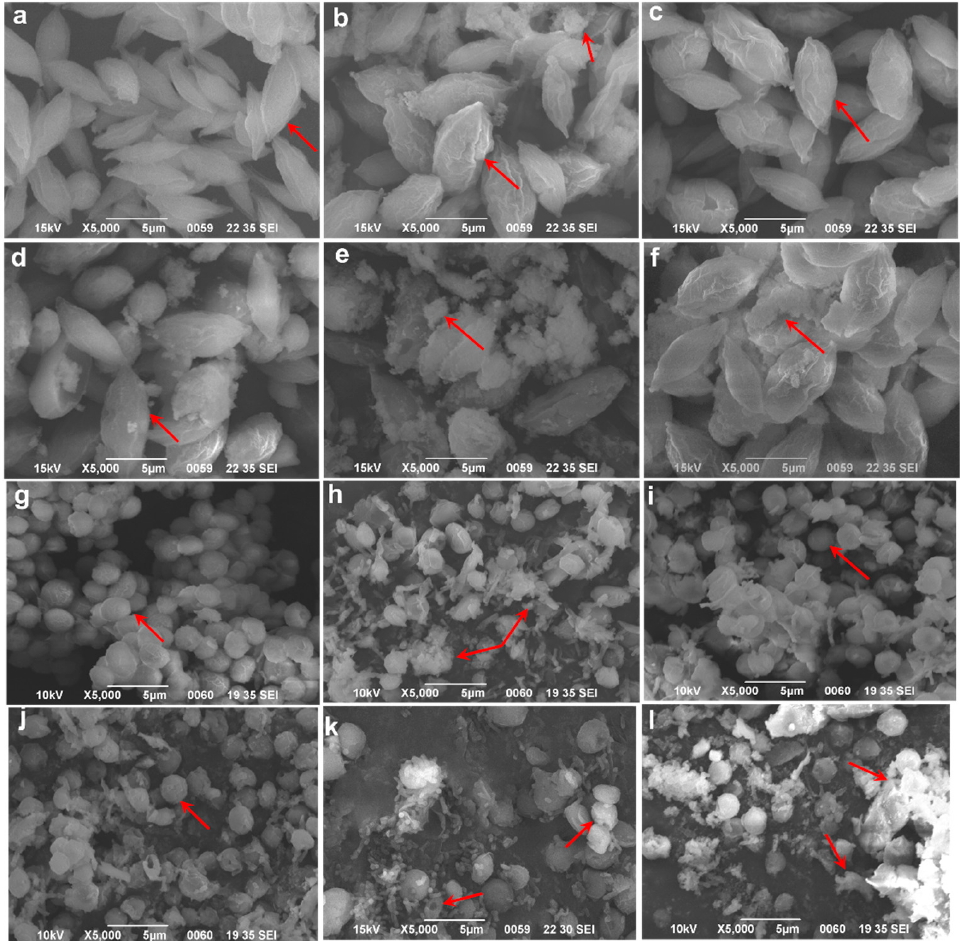
Figure 4. Effects of different concentrations of salicylic acid on the surface structures of S. obliquus ( a – f ) and C. pyrenoidosa ( g – l ) under Cd 2+ stress after 96 h (bar = 5 μ m) Note: ( a , k ): ck1; ( b , h ): ck2; ( c , i ): 30 mg/L; ( d , j ): 60 mg/L; ( e , k ): 90 mg/L; ( f , l ): 120 mg/L. All arrows in the figure indicate the phenomena described in the